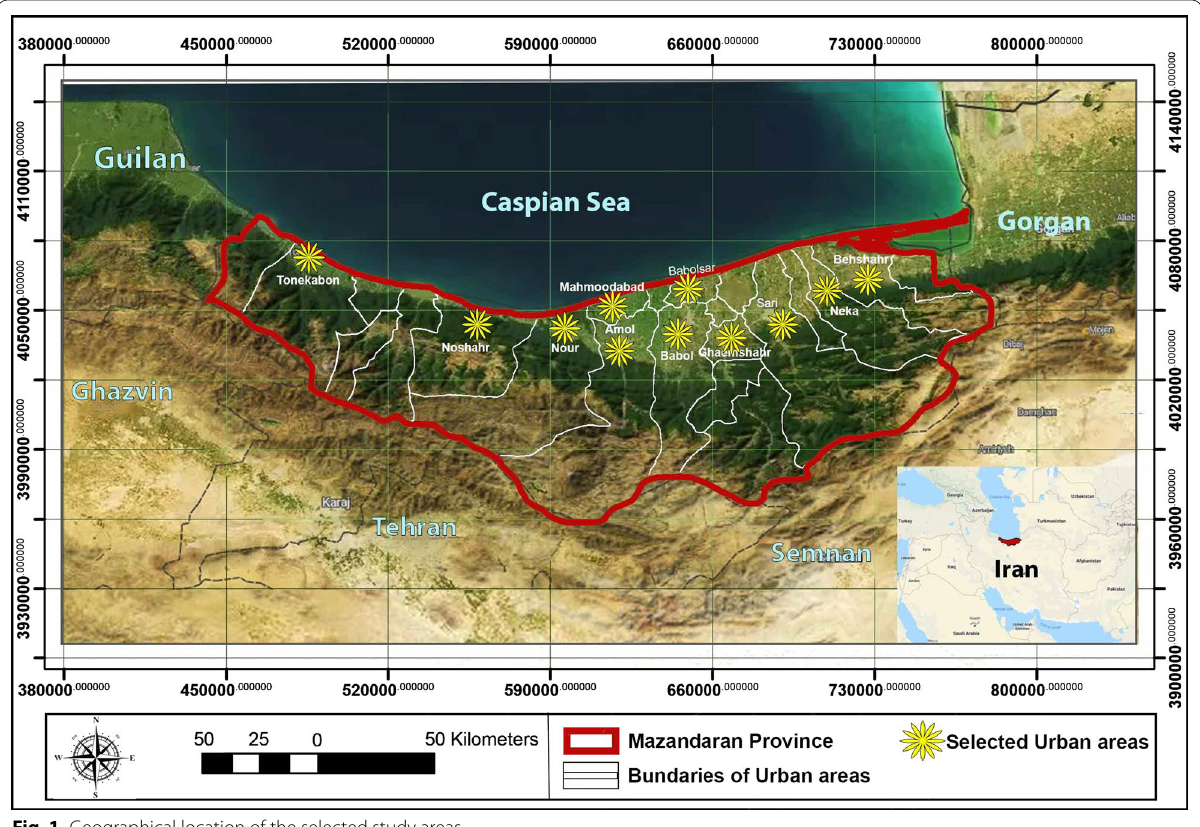
Fig. 1 Geographical location of the selected study areas